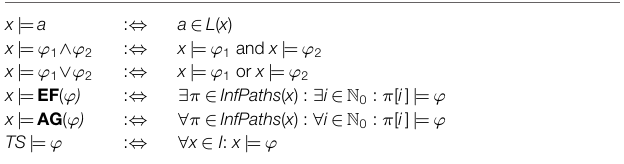
TABLE 1 | The satisfaction relation j = j = j = for CTL formulas φφφ , states x 222 S , and transition systems TS === ( S, !!! , AP, L, I ) . x | =